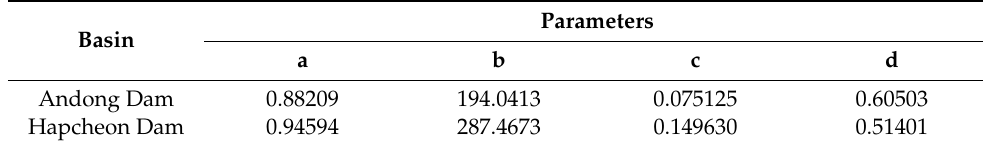
Table 2. Performance metrics of abcd model. Table 1. Parameters estimated for abcd model.